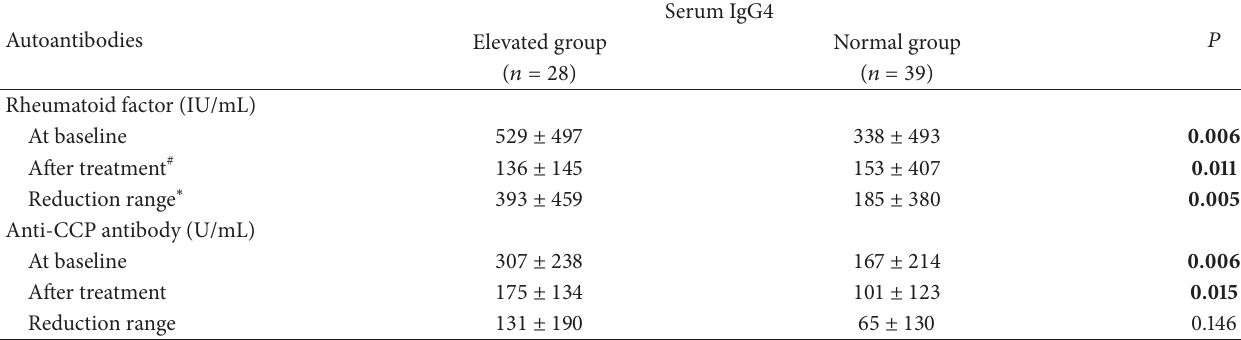
Table 2: Comparison of autoantibodies of 67 RA patients between normal and elevated serum IgG4 groups.